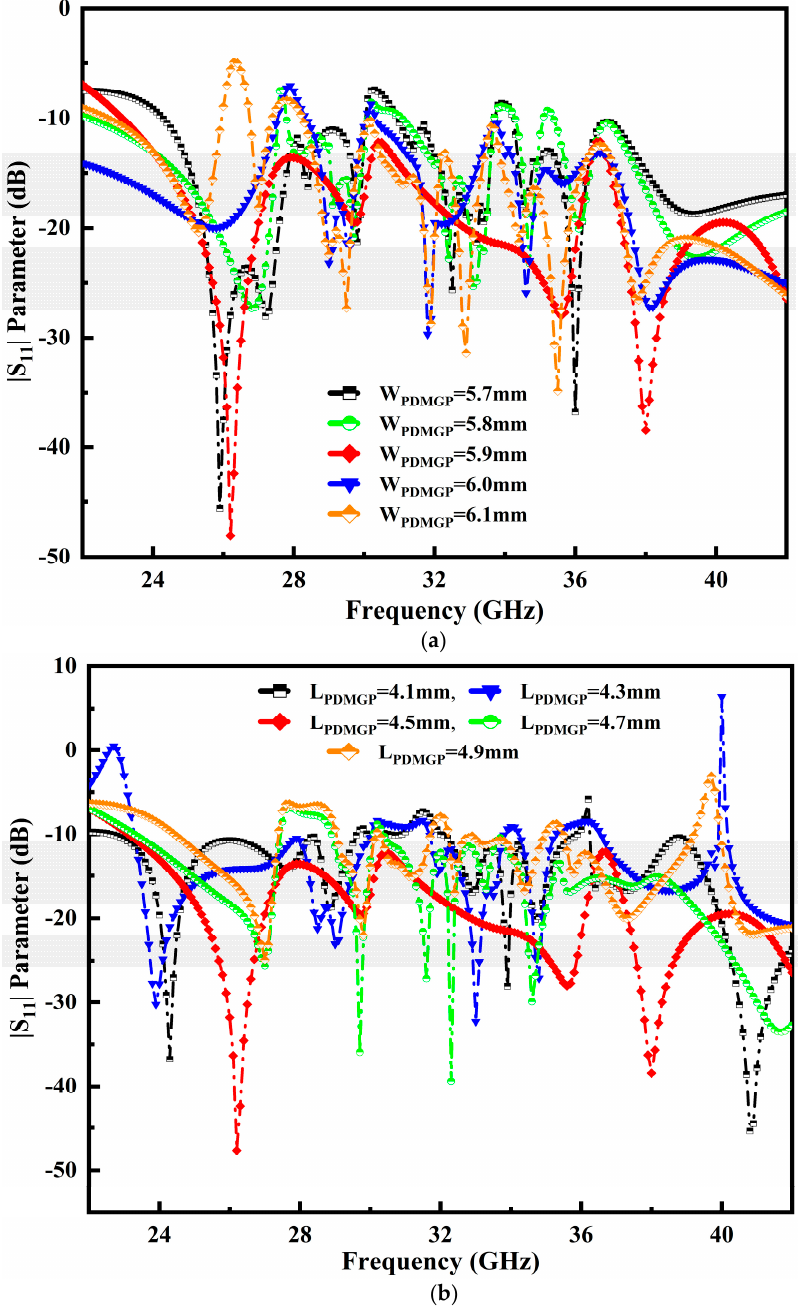
Figure 6. Performance of the parameters: ( a ) W PDMGP and ( b ) L PDMGP .